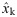
Predicted skill level at energy extraction throughout ontogeny plateaus in adulthood.Lines are the predicted skill level vs age with (A) power and (B) exponential competence for the results in Fig 3. Circles are the observed cumulative distribution of self-reported acquisition ages of food production skills in female Tsimane horticulturalists [81] multiplied by our x^k. However, note that the observed skills in Tsimane involve cumulative social learning which we do not model explicitly.